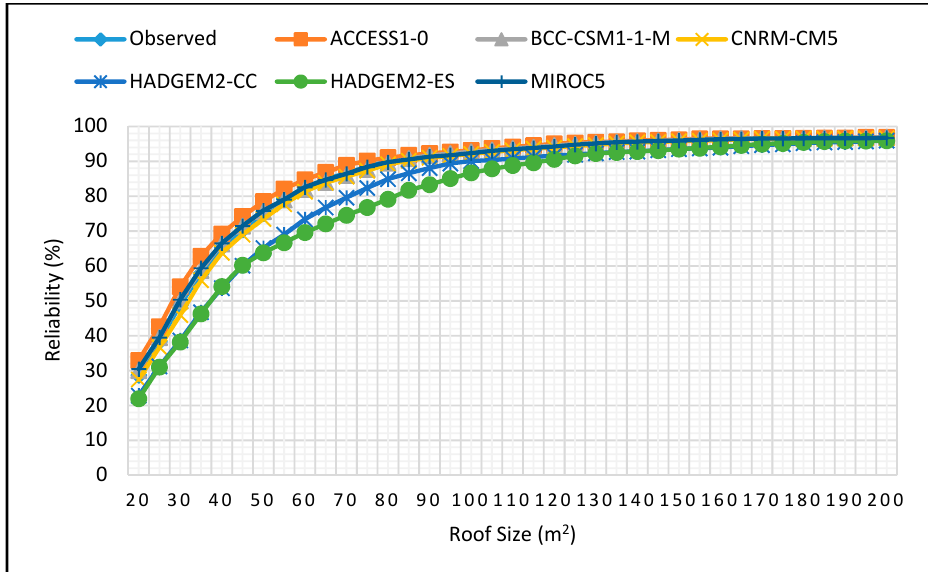
Figure 12. Reliability projections for DJF season for 2 m 3 tank size for 2025–2055.